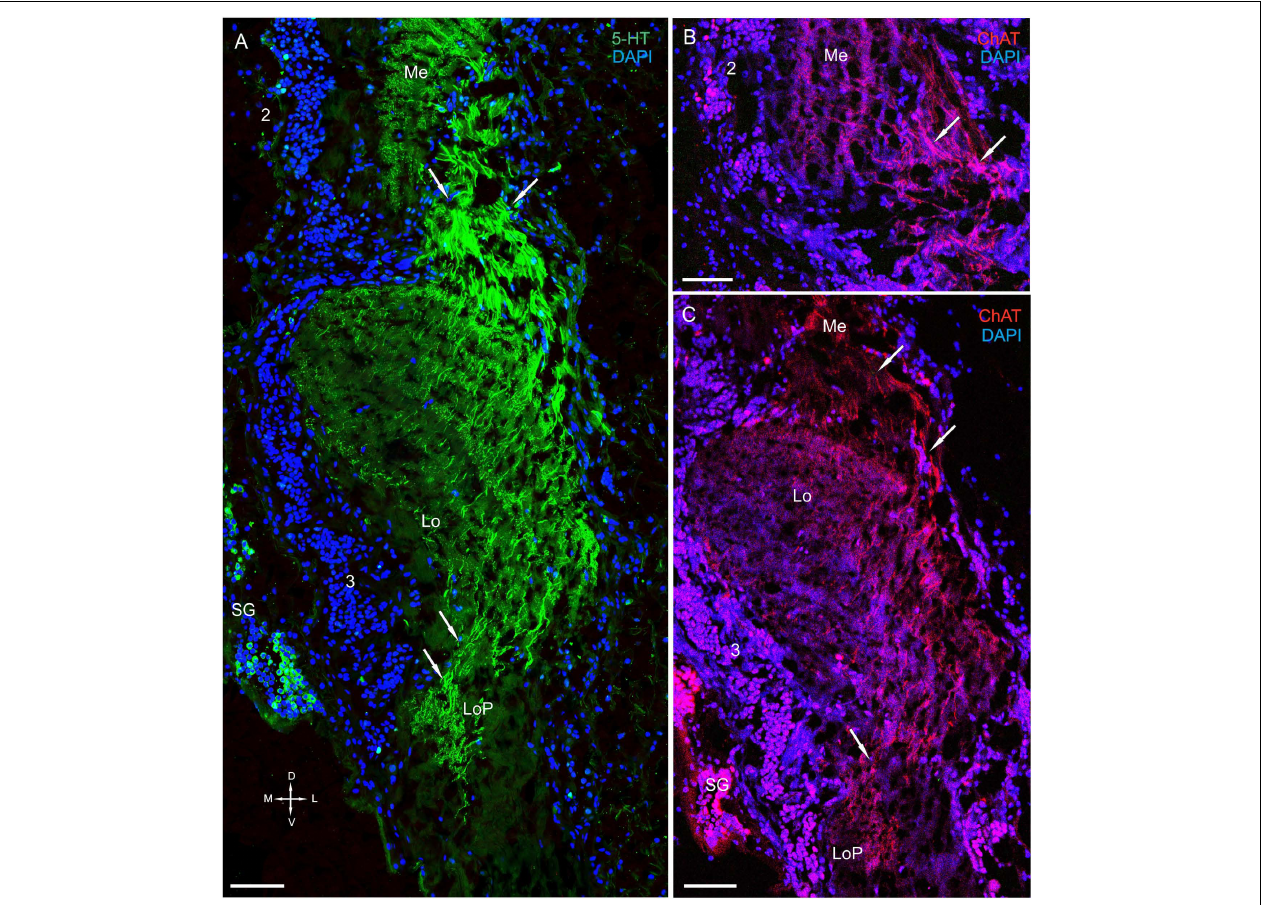
FIGURE 6 | Immunolocalization of 5-HT and ChAT in the lobula and the lobula plate. (A) 5-HT-positive nerve fibers in the Lo and LoP. (B) ChAT-positive nerve fibers between in the Me and Lo. (C) ChAT-positive nerve fibers in the Lo and LoP. Arrows indicate immunoreactive nerve fibers. Green, 5-HT; red, ChAT; blue, DAPI. Scale bars = 100 µ m. Me, medulla; Lo, lobula; 2, 3 cell clusters; LoP, lobula plate; D, dorsal; V, ventral; L, lateral; M,